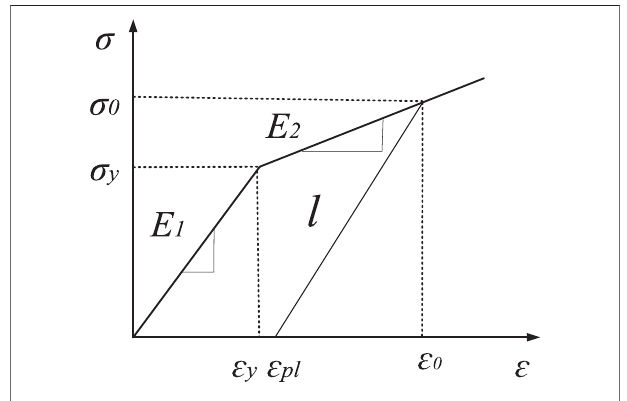
FIGURE 1 | Stress and strain curves of the steel pipeline.